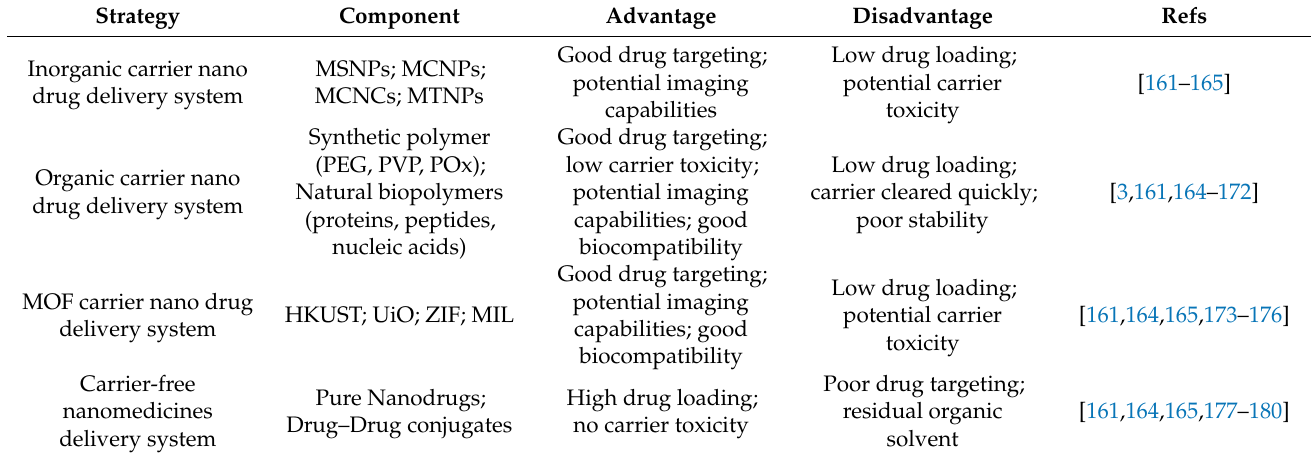
Table 3. Summary of advantages and disadvantages of carrier and carrier-free drug delivery.